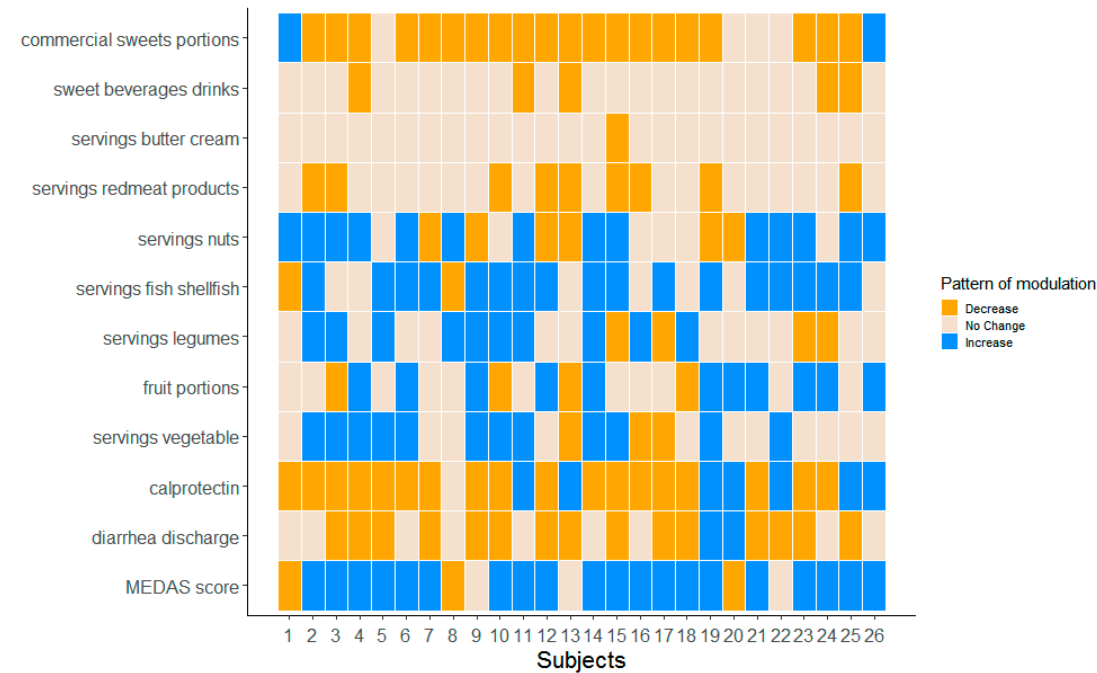
Figure 5. Heatmap FAP-patient level. Representation of the MEDAS questionnaire data of the 26 considered patients together with the number of diarrheal discharges and fecal calprotectin.